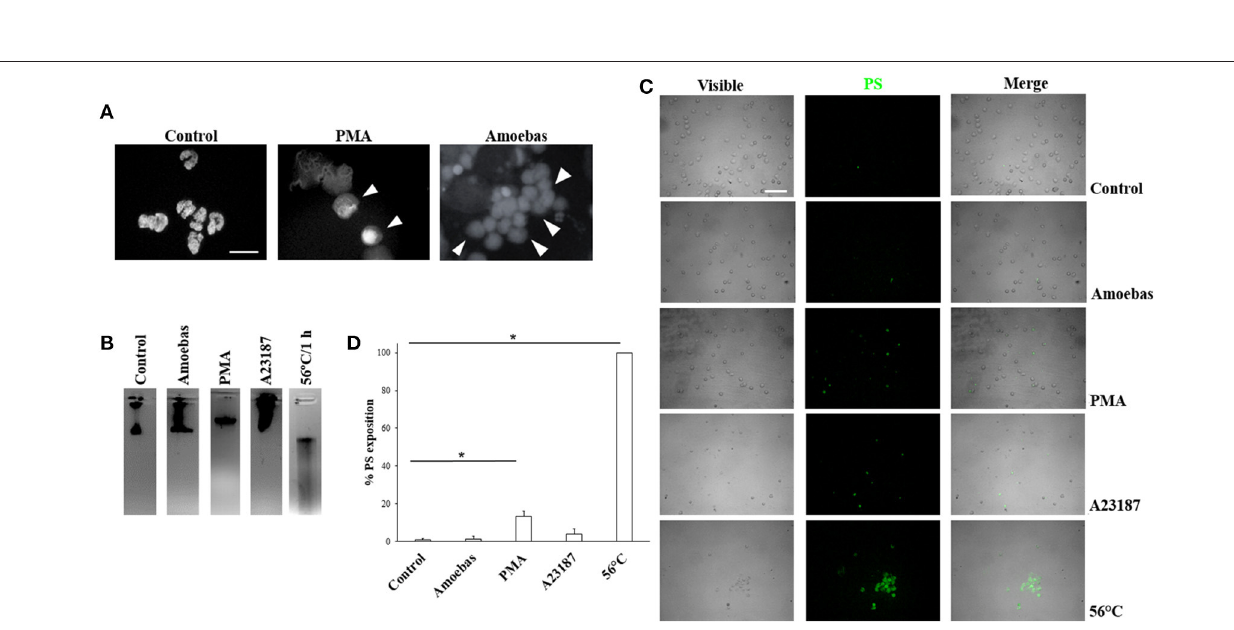
Frontiers in Cellular and Infection Microbiology | www.frontiersin.org